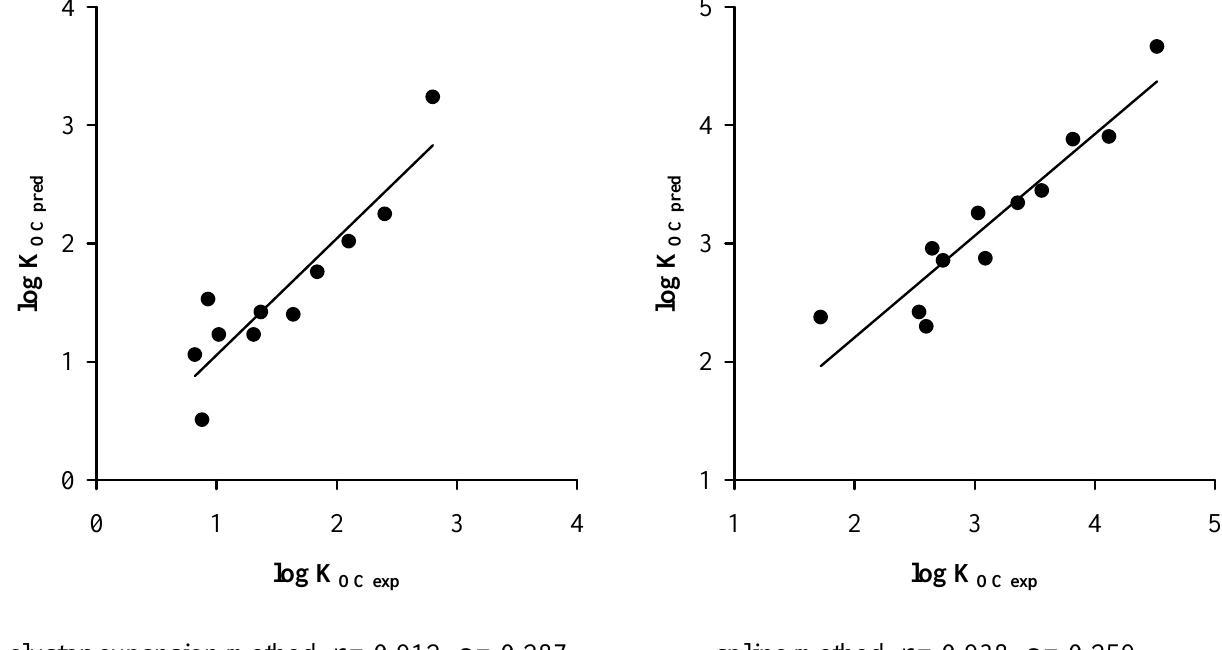
Figure 4. Plot of experimental vs. predicted soil sorption coefficient for chlorophenols with the cluster- expansion and splinoid poset QSSPR